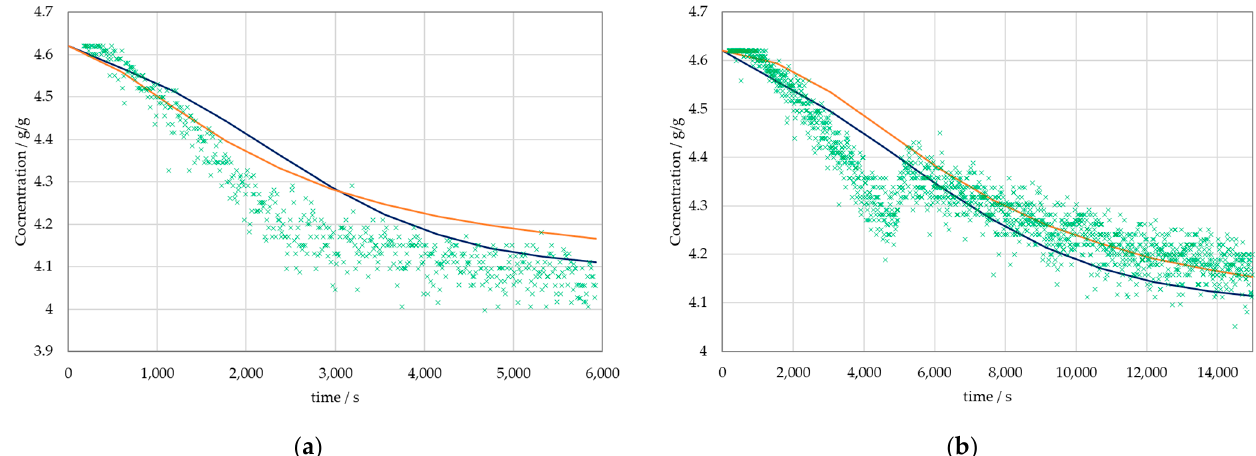
Figure 7. The concentration courses for two different experiments (a) and (b). Green crosses are measured data, the dark blue line is the sigmoid function fit described in the methods, the orange line is the result of the model.